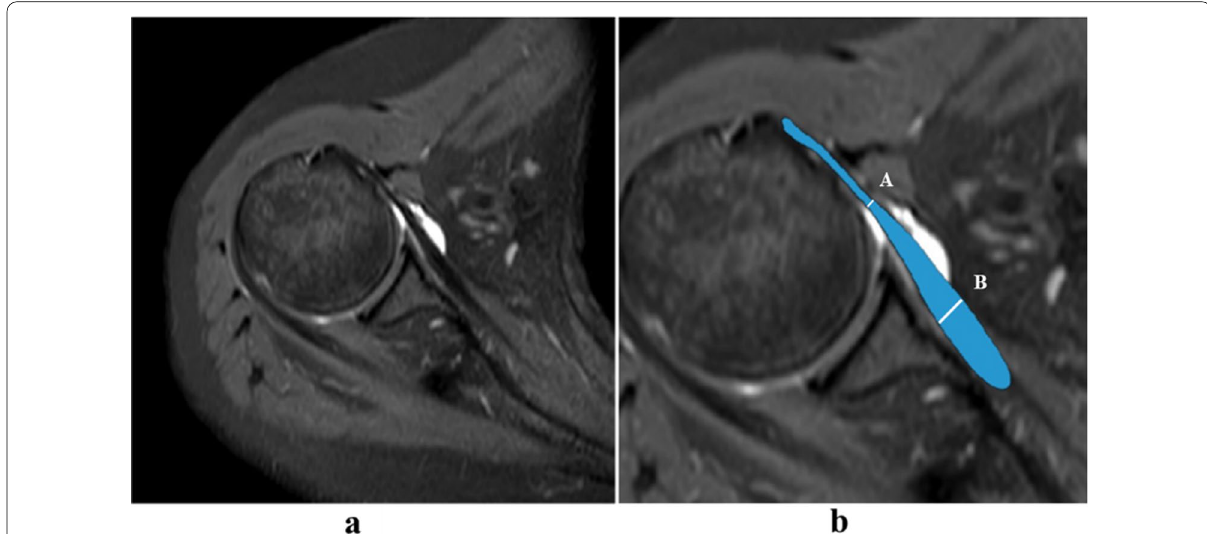
Fig. 3 Evaluation of thinning of SSC tendon on axial IM-WI/fs MRI. Manually measuring the diameter of the SSC tendon at its thinnest proximal point ( a ) and its thickest distal point ( b ), and the ratio of a and b is < 1/3 as the reference value of thinning of the SSC tendon